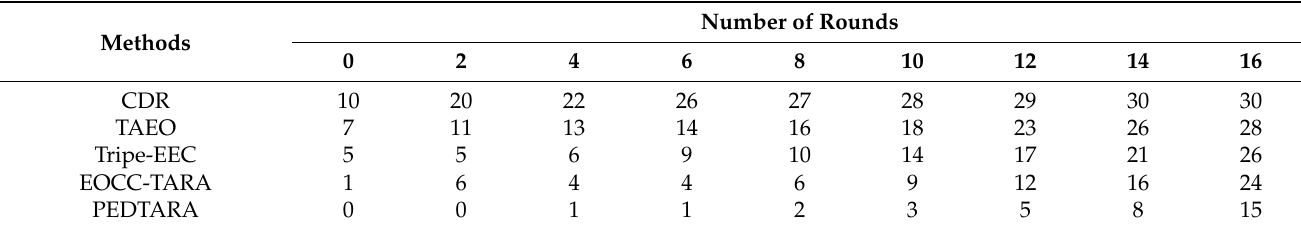
Table 12. Percentage of heated